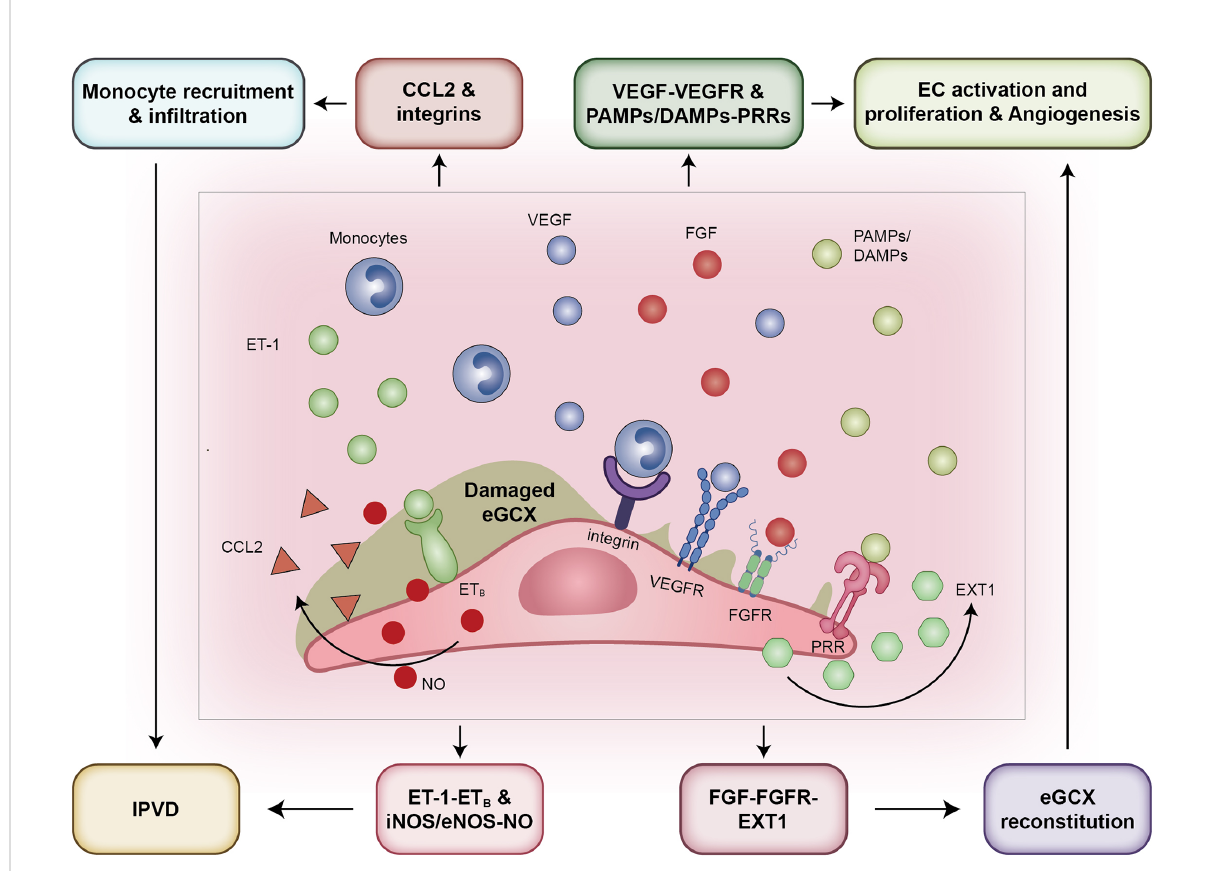
FIGURE 5 The pathways that eGCX adopts to participate in HPS pathogenesis. From the left to the right: First, eGCX degradation promotes the contact of monocytes with the endothelium by exposing adhesion molecules such as integrins and selectins, contributing to elevated expression of iNOS and eNOS and subsequently NO release. Second, the exposure of receptor ET B when bound by ligand ET-1 increased the release of NO as well. Third, the VEGF-VEGFR and FGF-FGFR signals activated after eGCX degradation promote the migration and proliferation of ECs, facilitating the sprout of neovessels. Fourth, the FGF-FGFR signal activates the downstream enzyme EXT1 to reconstitute the eGCX layer within the injured site and neovessels. Abbreviations: eGCX, endothelial glycocalyx; IPVD, intrapulmonary vascular dilation; CCL2, C-C motif chemokine ligand 2; ET-1, endothelin-1; ETB, type B endothelin receptor; VEGFR, vascular endothelial growth factor receptor; FGFR, fi broblast growth factor receptor; PAMPs, pathogen associated molecular patterns; DAMPs, damage associated molecular patterns; PRRs, pattern recognition receptors; PRRs, pattern recognition receptors; NO, nitric oxide; iNOS, inducible nitric oxide synthase; eNOS, endothelial nitric oxide synthase; EXT1, exostosin 1; EC, endothelial